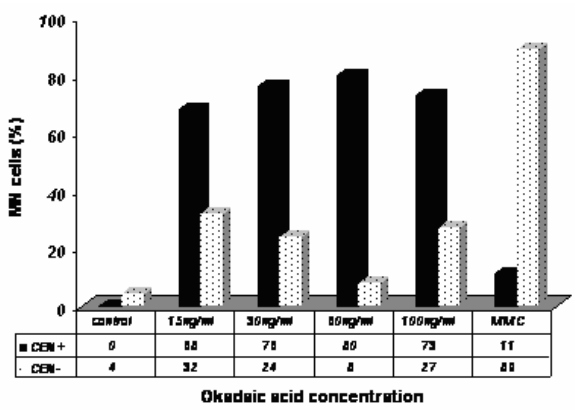
Figure 4: FISH analysis in Caco-2 cells after 24h exposure to OA. MN=number of micronucleated cells; CEN+= MN containing one or more centromeric signals (percentage); CEN-= MN containing no centromeric signal (percentage); MMC= Mytomicin C (clastogenic compound). Results presented are yielded by 3